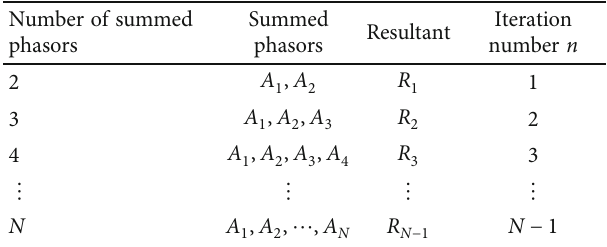
Figure 3: (a) n phasors f A angular spacings f β 1 , β 2 , β 3 , ⋯ , β N − 1 g .